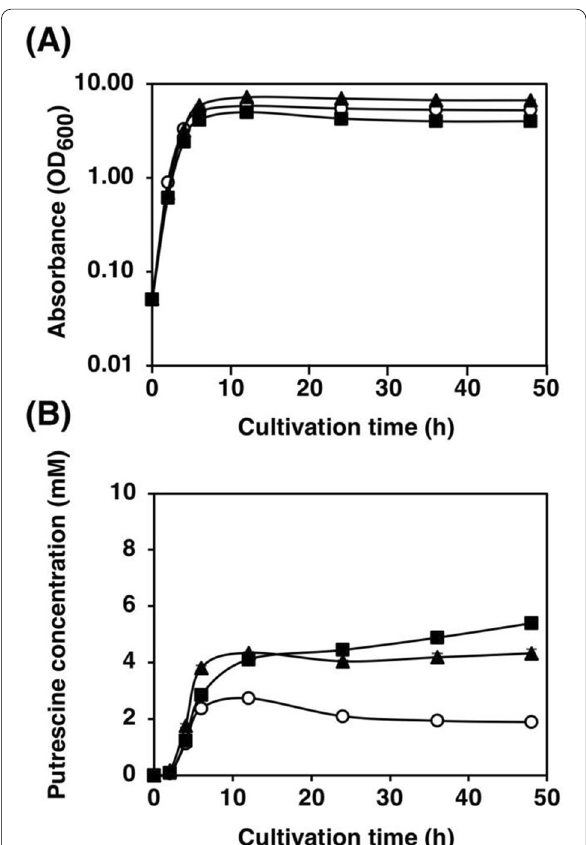
Fig. 3 Effect of SpeA, SpeB, and SpeC on putrescine production. A Bacterial cell growth and B putrescine concentration in the supernatant of strains FS123 ( speC + , open circle), KN20 ( speABC + , closed triangle), and KN24 ( speAB + , closed square) grown in LB medium supplemented with 100 μg/mL of ampicillin. When the OD 600 reached 0.4, 0.02 mM IPTG was added. Data shown are averages standard deviations, and culture experiments were ± performed in